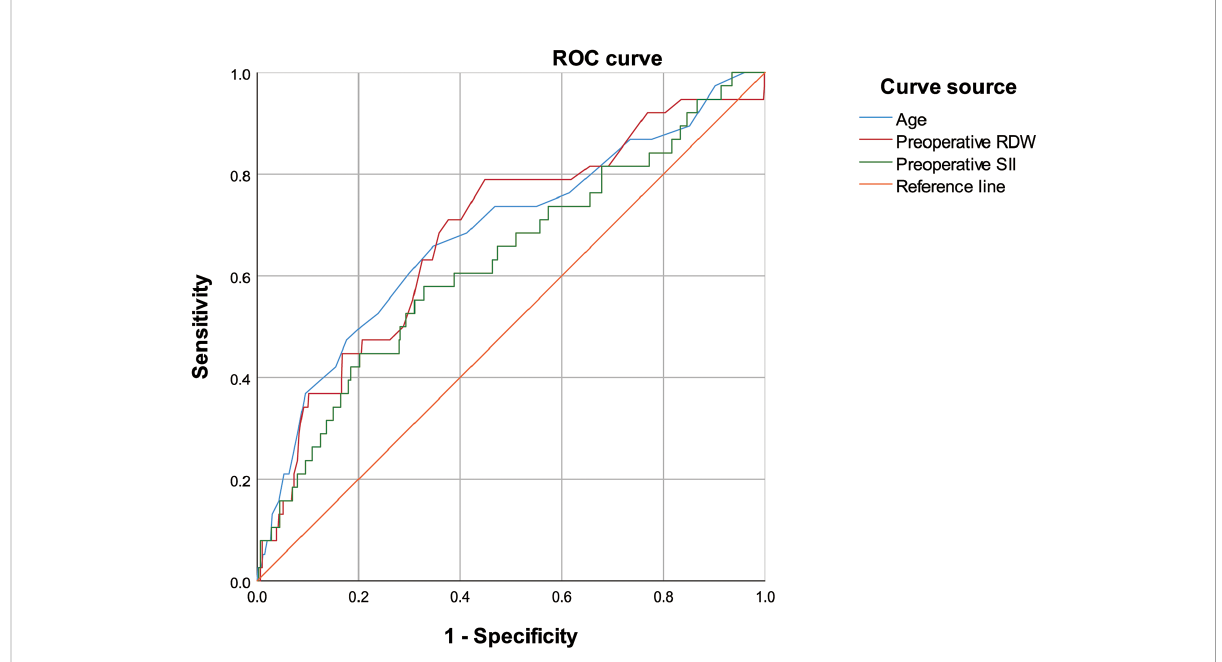
FIGURE 2 Receiver operating characteristic curve of age, preoperative red blood cell distribution width, and preoperative systemic in fl ammatory index for predicting postoperative pulmonary